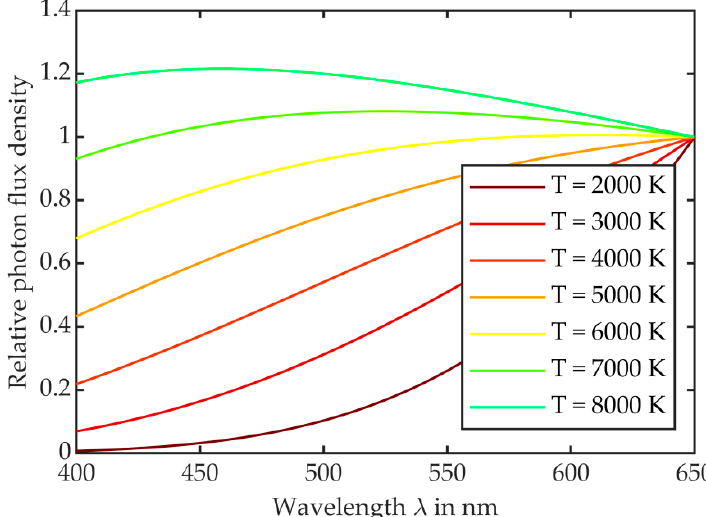
Figure A2. Modeled thermal emission spectra in the investigated spectral range for temperatures between 2000 K and 8000 K.